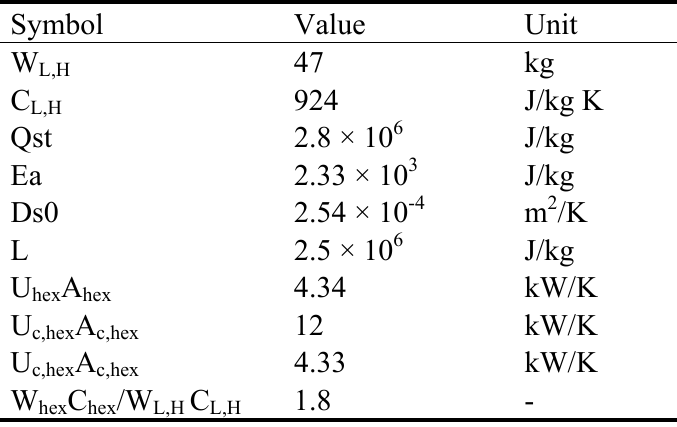
Table 4. Value adopted in simulation